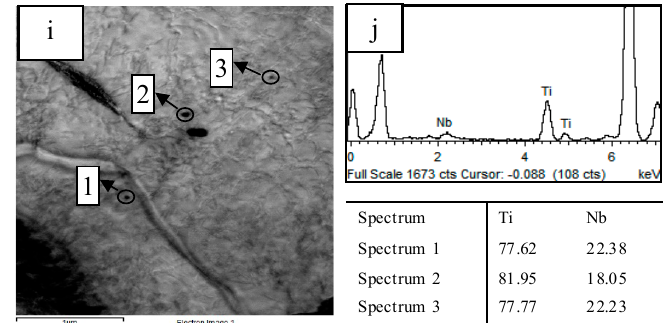
Figure 12. TEM micrographs showing microstructure of experimental steels in the simulated CGHAZ. ( a , b ) 18 kJ/cm; ( c , d ) 25 kJ/cm; ( e , f ) 44 kJ/cm; and ( g – j ) 81 kJ/cm.